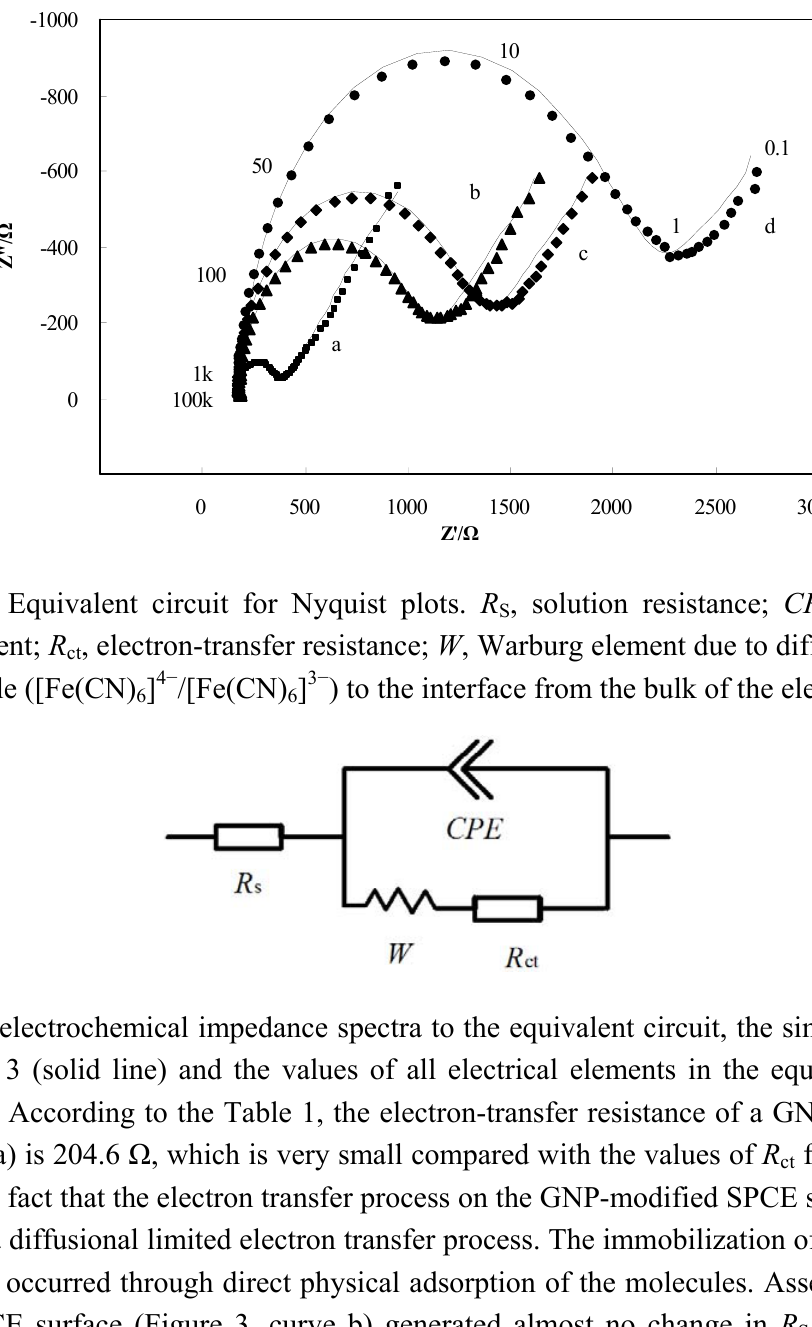
Figure 3. Nyquist diagrams and the corresponding simulated results (solid line) of GNP-SPCEs obtained under the following conditions: ( a ) at the bare GNP-SPCE; ( b ) after antibody immobilization; ( c ) after blocked with BSA; and ( d ) after Brucella melitensis cells (4 × 10 5 CFU/mL) binding in the frequency range from 0.1 Hz to 100 kHz. A sinusoidal potential modulation of ±5 mV amplitude was superimposed on the open circuit potential (0.13 V). Electrolyte: 2.5 mM K KCl + 10 mM PBS (pH = 7.4).